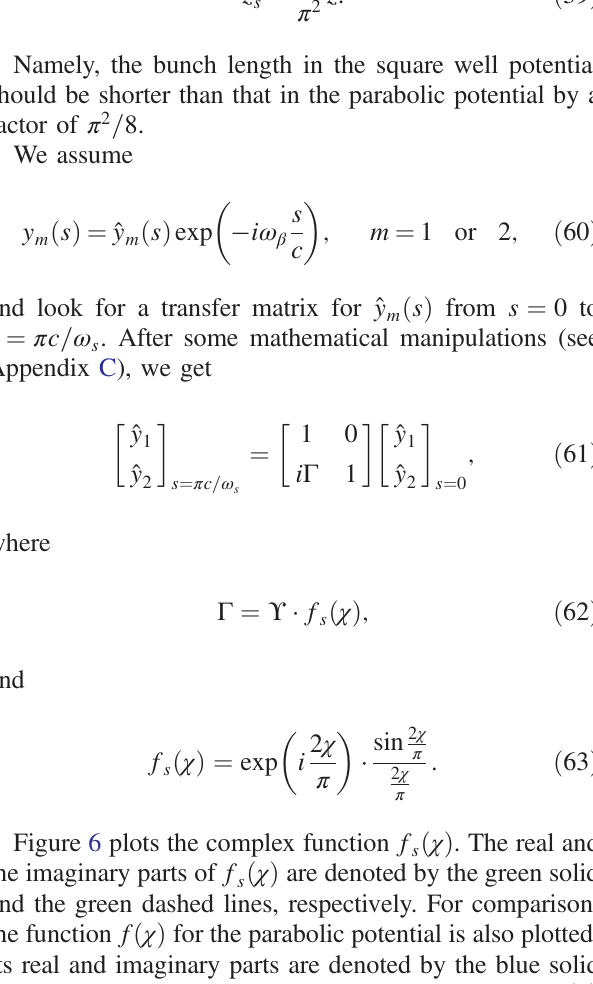
as a function of ϒ and χ s